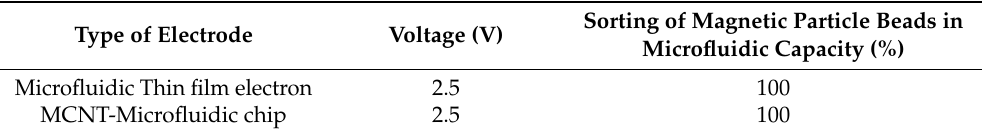
Figure 8. The flow of the magnetic particle in the microstructure flow channel with microfluidic chip. Table 4. Separation of sample magnetic particle beads with microfluidic chip and MWCNT- microfluidic chip.